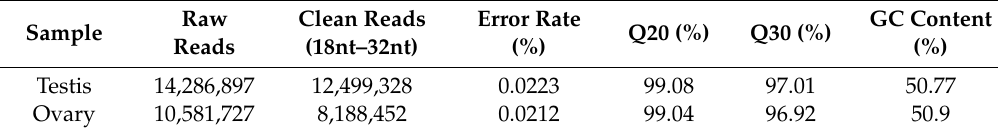
Table A2. Overview of small RNA sequenced data.